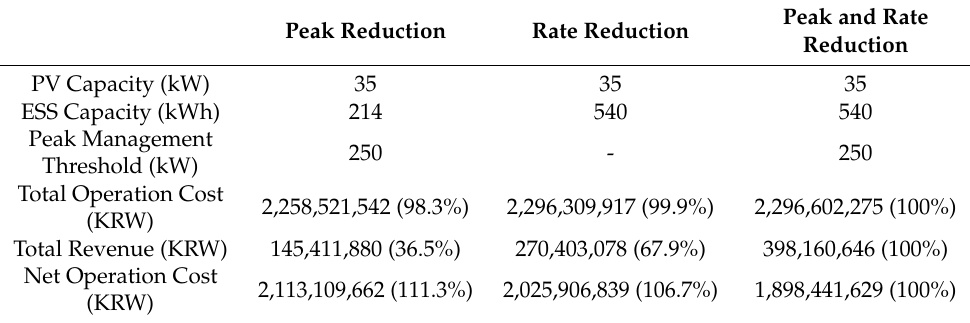
Table 8. Optimal capacity and net cost comparison.